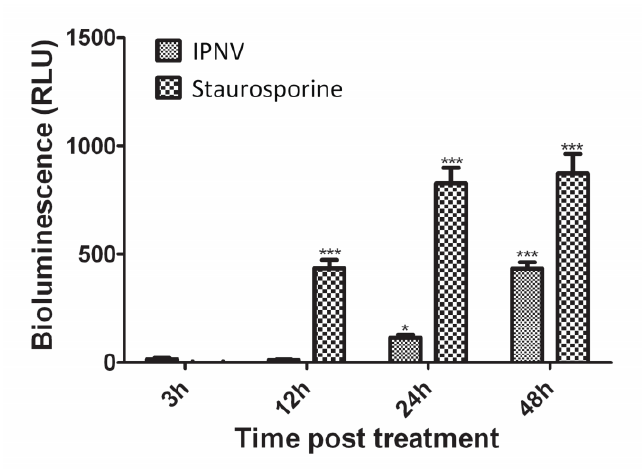
Figure 7. Caspase 3 activity in cells infected with infectious pancreatic necrosis virus. Cells were infected with IPNV or treated with 2.5 µM staurosporine (positive control) for the indicated periods. Uninfected and untreated cells were used as negative controls. Caspase 3 activity was assessed by measuring the bioluminescence resulting from cleavage of a luminogenic substrate using Caspase-Glo ® 3/7 assay kit (promega). The bars represent the relative luminescence units after subtracting the mean values obtained from the uninfected/untreated cells. Bars represent means of data obtained from two independent experiments each conducted using three parallels ± S.E.M. Statistical significance compared to cells treated at 3 h is indicated by asterisks; * = p < 0.05; *** = p <